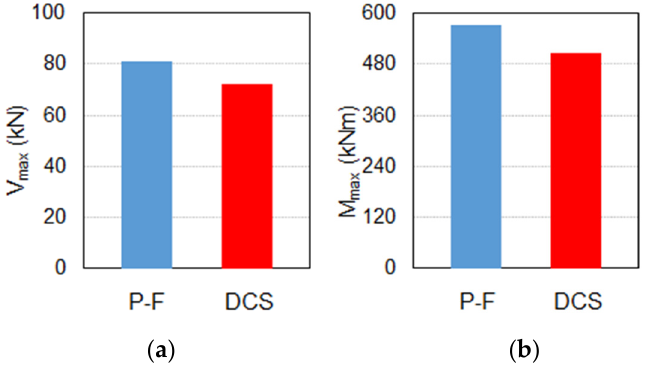
Figure 16. Comparison of the seismic performance of DCS and pure friction (P-F) joint: ( a ) maximum base shear force in the columns; ( b ) maximum bending moment in the columns.